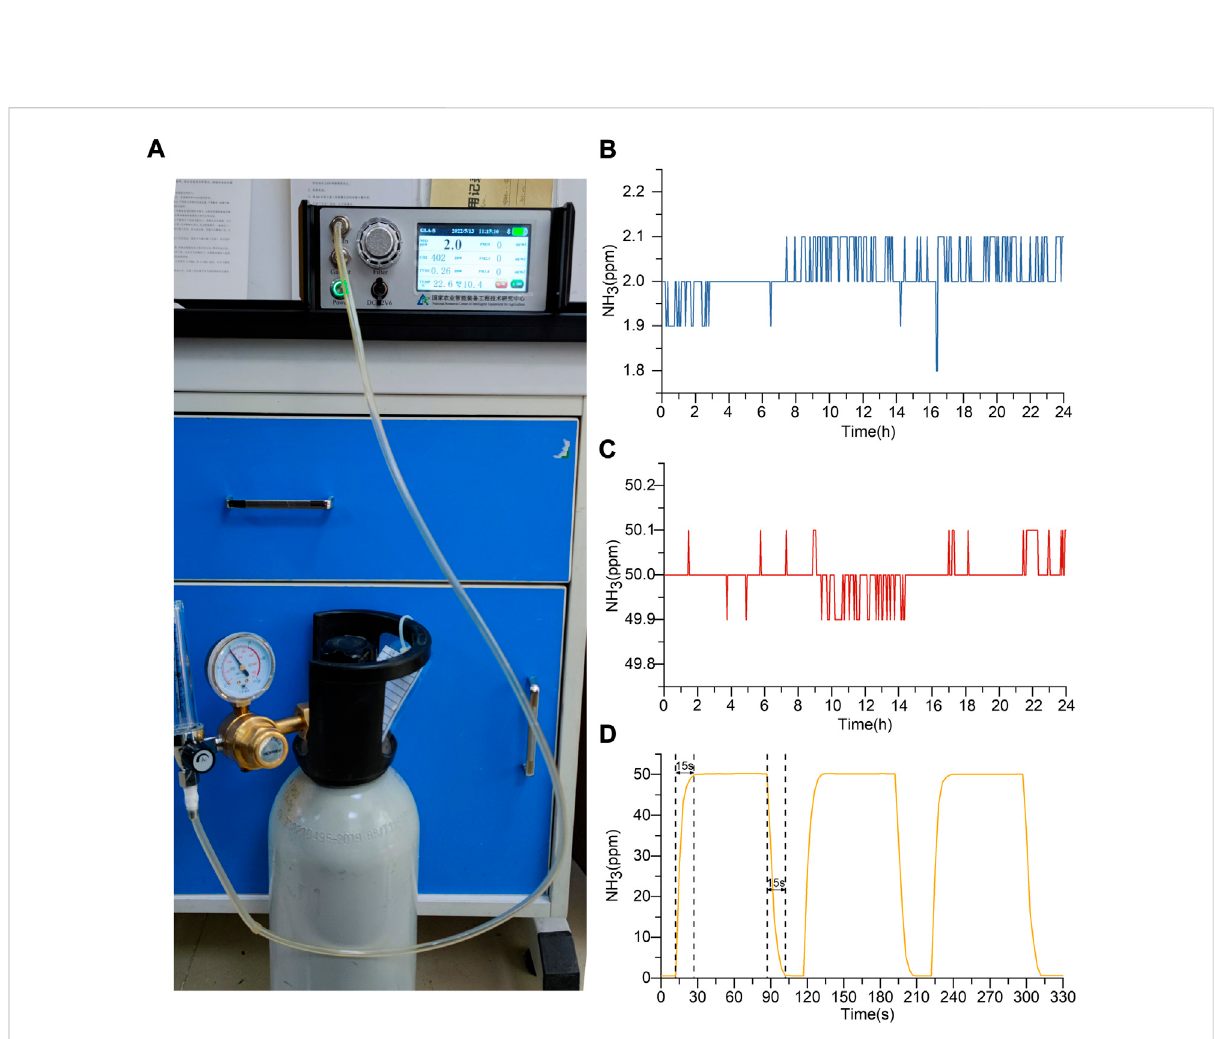
FIGURE 3 (A) Photographofmeasuringstandardammonia; (B) Monitoringdatafor2 ppmammoniawithin24 h; (C) Monitoringdatafor50 ppmammonia within 24 h; (D) Repeat measurement of 50 ppm